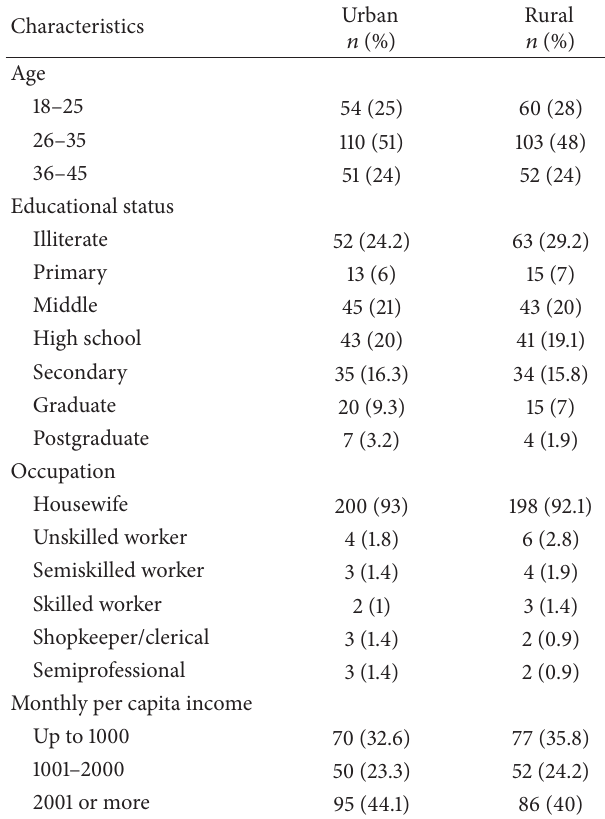
Table 1: Sociodemographic characteristics of the study subjects of urban and rural area ( 𝑛 = 215